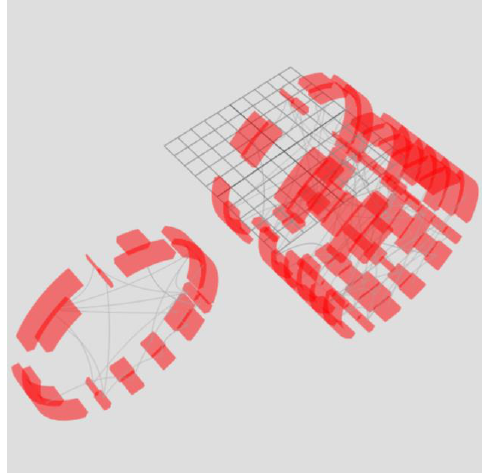
Figure 13. Stacked chord diagram. Each chart represents one-time slice. The arrangement of arc elements of the ring one after another provides information about the change in the parameter over time by analogy with a flowchart.